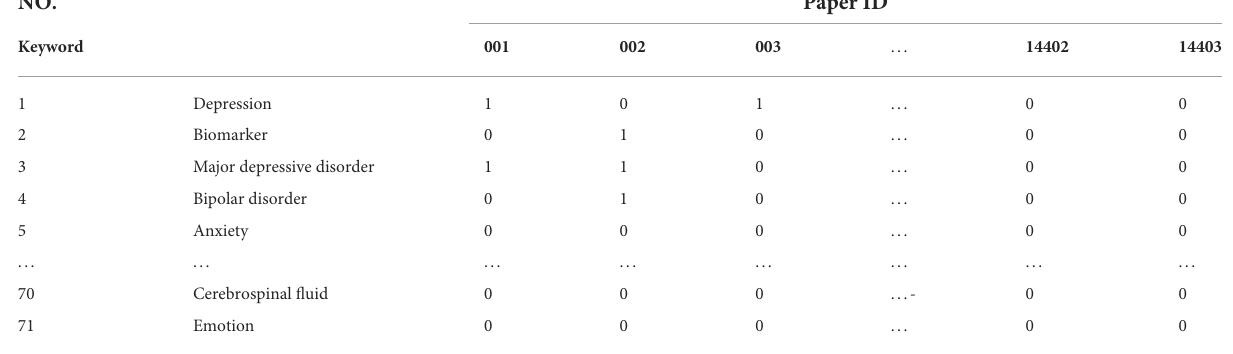
TABLE 4 Binary matrix table of depression biomarker high-frequency keywords and